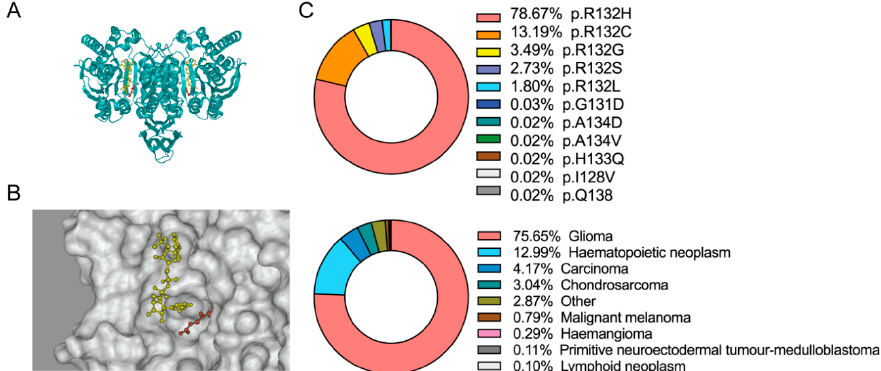
Figure 2. Cancer-associated- IDH1 mutation. ( A ) Ribbon diagrams of the IDH1 structure in Homo sapiens . NADP is highlighted in yellow. α -Ketoglutarate ( α -KG) is highlighted in red. The structure is visualized based on the known crystallography 4KZO [55]. ( B ) The structure of the catalytic center of the IDH1 enzyme. NADPH is highlighted in yellow. α -KG is highlighted in red. The structure is visualized based on the known crystallography 4KZO. ( C ). The frequency of IDH1 somatic mutations (upper panel) and IDH1 mutations in human malignancies (lower panel). Percentages were calculated from the Catalogue of Somatic Mutations in Cancer (COSMIC) database